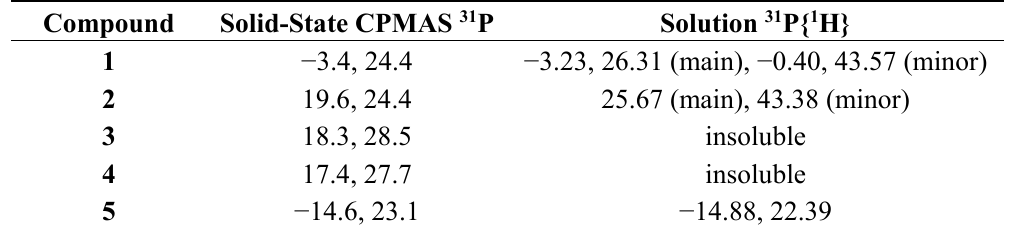
Table 2. Solid-state cross-polarization magic-angle-spinning (CPMAS) 31 P and